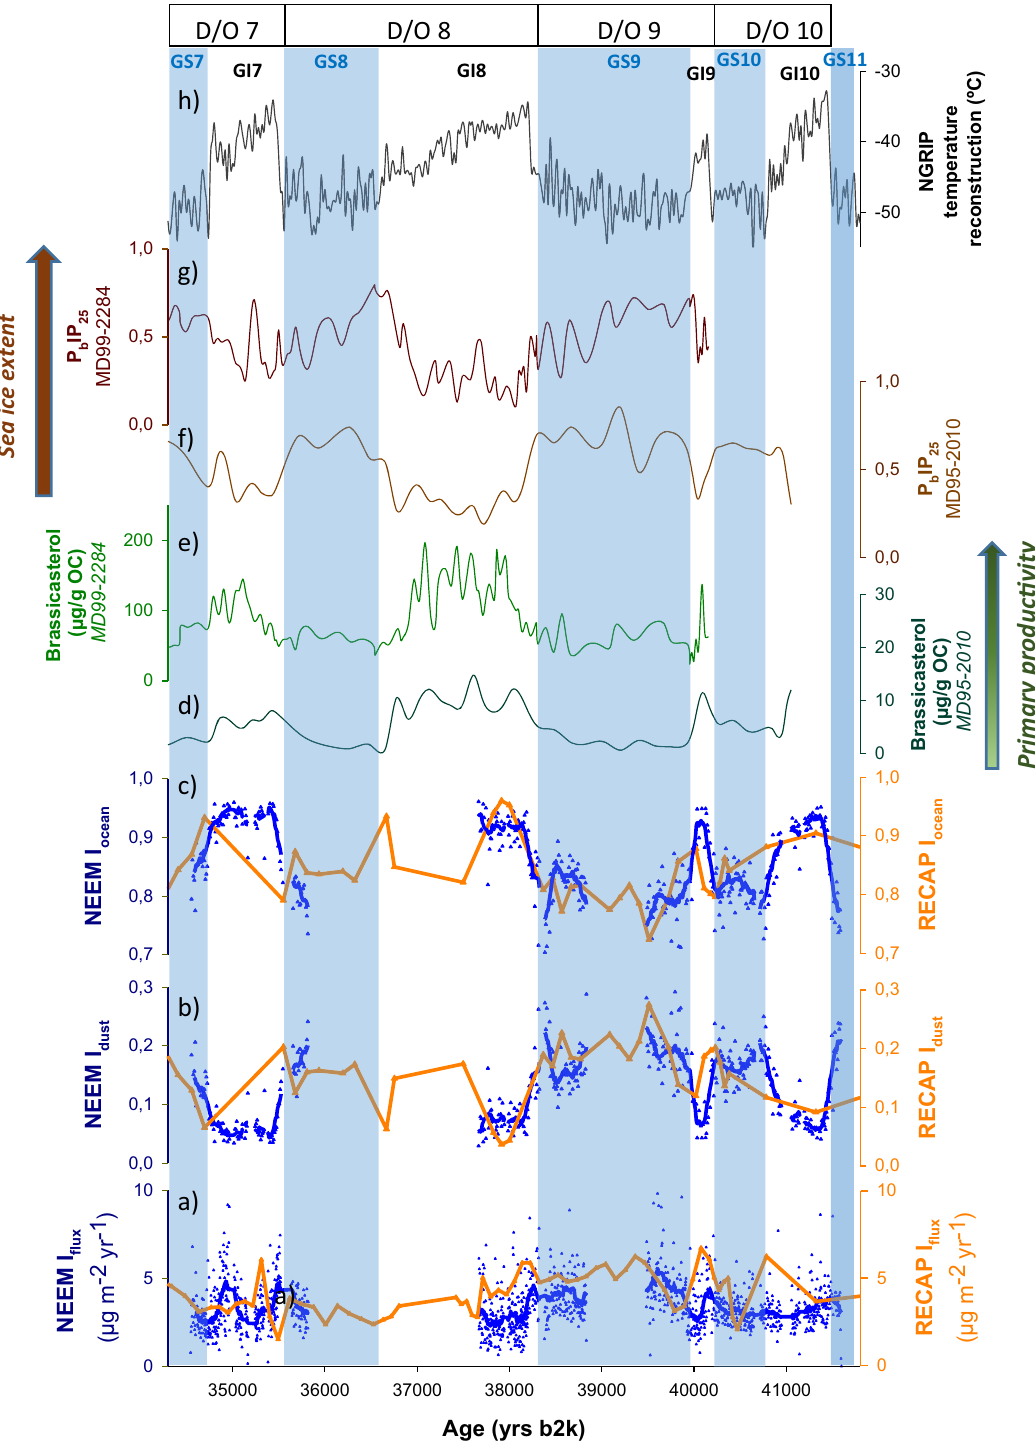
Fig. 3 High-resolution iodine level variability in Greenland NEEM and RECAP ice cores from 34 to 42 kyr b2k ( = D/O 7 to 10). From bottom to top: a high-resolution NEEM (dark yellow) and RECAP (red) iodine depositional fl uxes (I fl ux ), b , c dust-related iodine (I dust ) and reconstructed ocean iodine emissions (I ocean ), with dark yellow lines representing the 11-sample running average in NEEM; d , e Arctic primary productivity and f , g sea ice evolution ( brassicasterol and P B PIP 25 pro fi les, respectively) from sediment cores in the Norwegian Sea 48,49 ; h Greenland air temperature reconstruction from NGRIP 64 . Blue and white bands represent Greenland interstadials (GIs) and stadials (GSs),